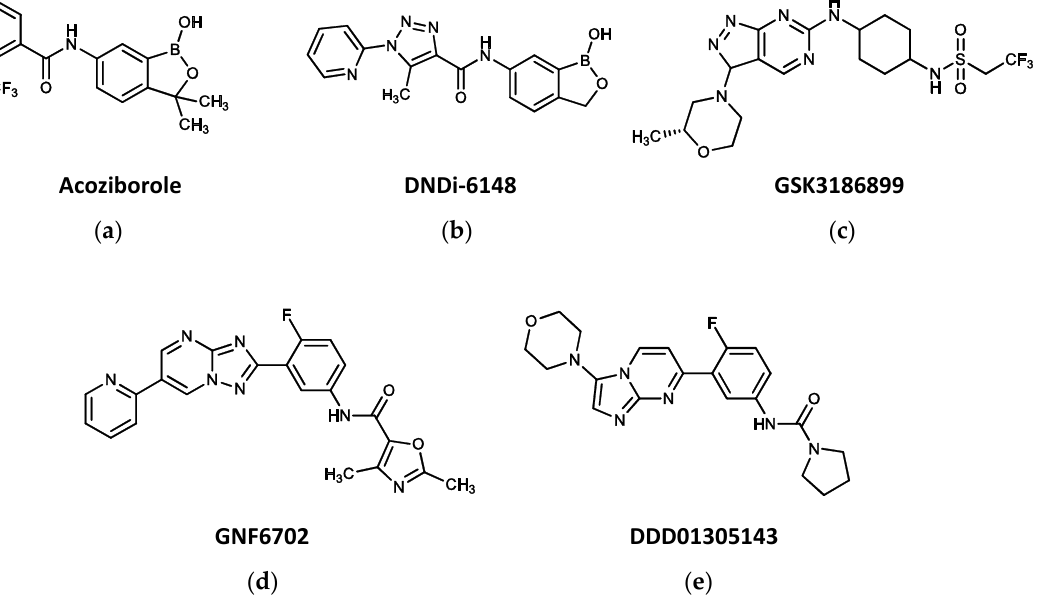
Figure 4. New drugs entering clinical trials against trypanosomatids. ( a ) Acoziborole. ( b ) DNDi-6148. ( c ) GSK3186899. ( d ) GNF6702. ( e ) DDD01305143.